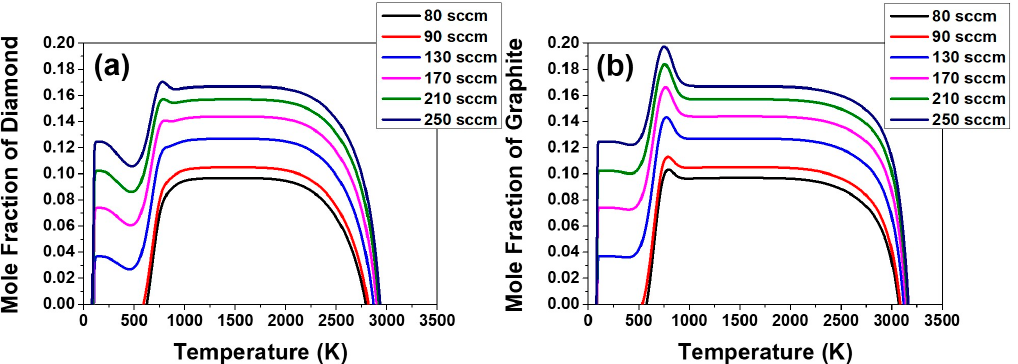
Figure 9. Equilibrium mole fraction of ( a ) diamond and ( b ) graphite for acetone fluxes of 80, 90, 130, 170, 210 and 250 sccm at 4000 Pa as a function of temperature.